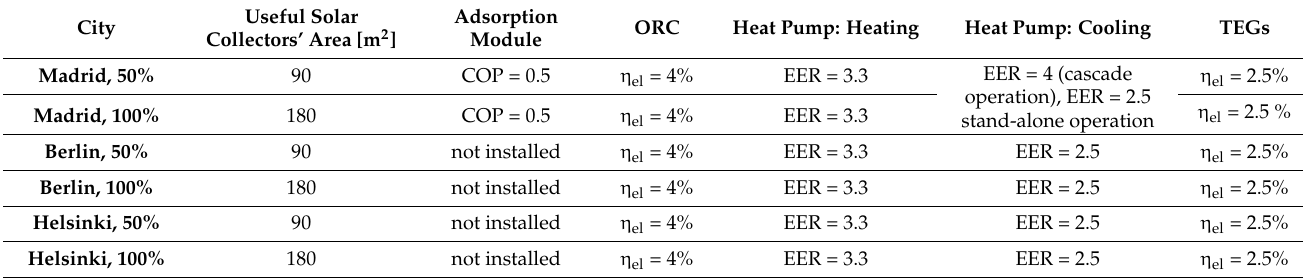
Table 1. Summary of simulations and main